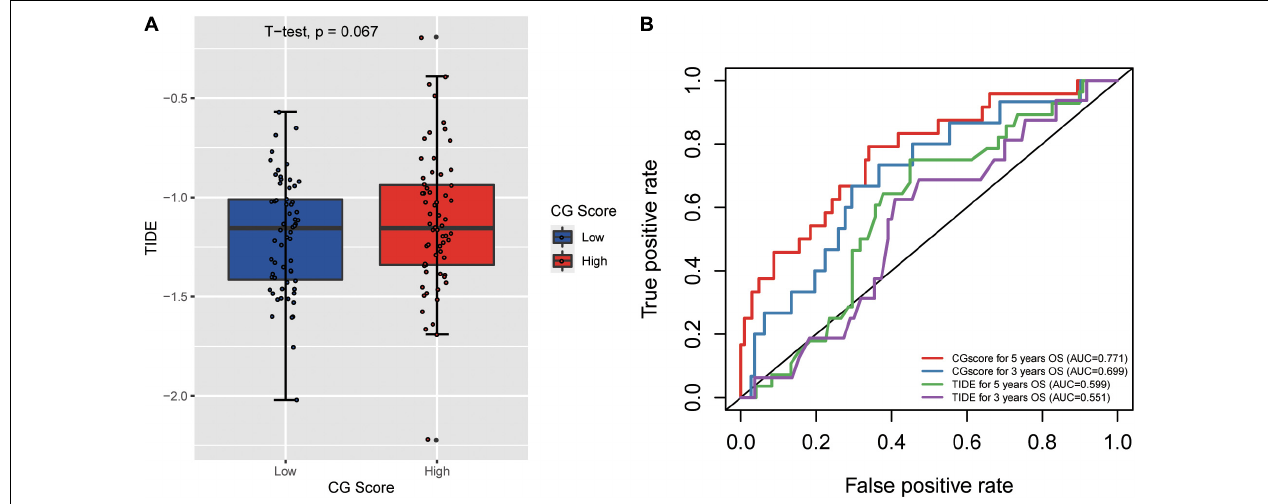
FIGURE 6 | (A) Correlation between tumor mmune dysfunction and exclusion (TIDE) and CG Score. (B) The performance of the CG Score and TIDE for overall survival in CRC.